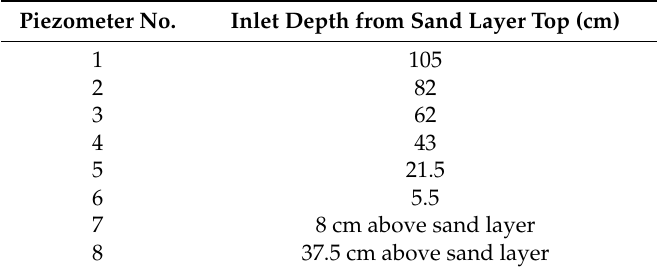
Table 1. Piezometer distribution.